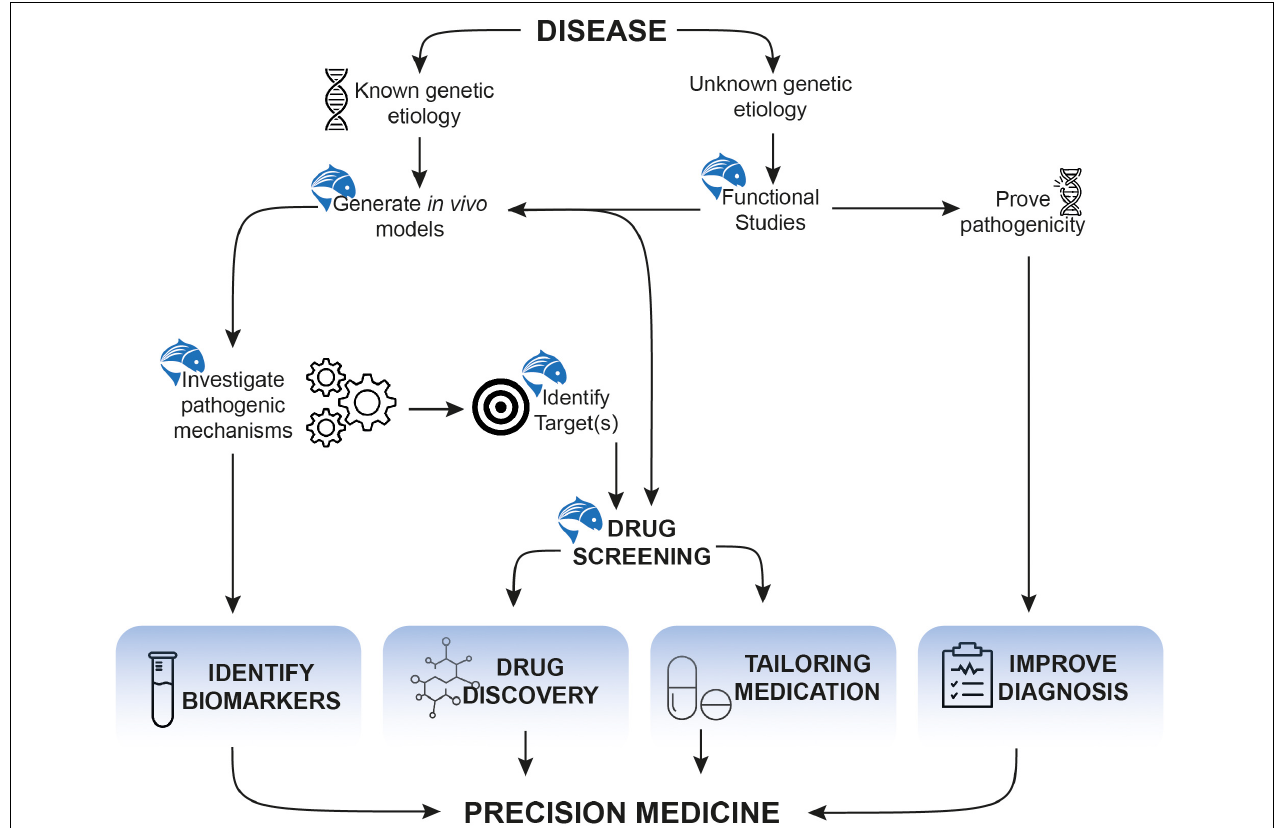
FIGURE 3 | Accelerating the development of precision medicine approaches using